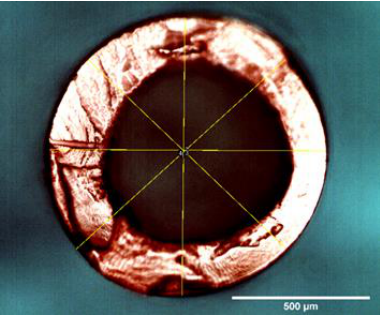
Figure 4. Cross-sectional image of a wet CHF obtained from optical microscope.